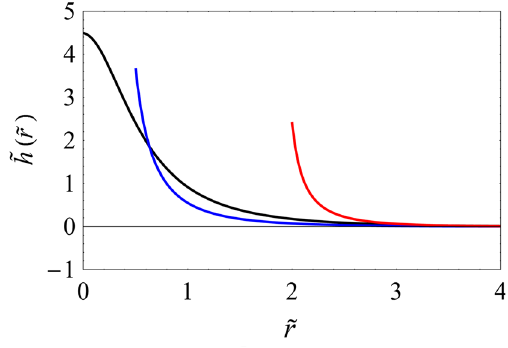
Fig. 2 The rescaled Higgs field outside a black hole with rescaled radius ˜ R h = 0 . 01 , 0.5, 2 (lines from left to right)